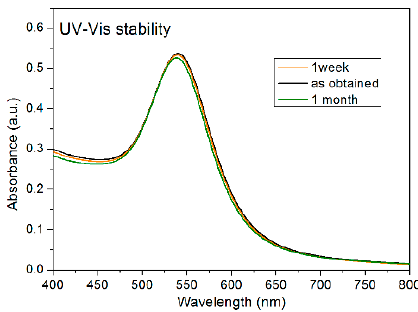
Figure 3. UV-Vis spectra of the AuNPs after one week and one month from the synthesis process.